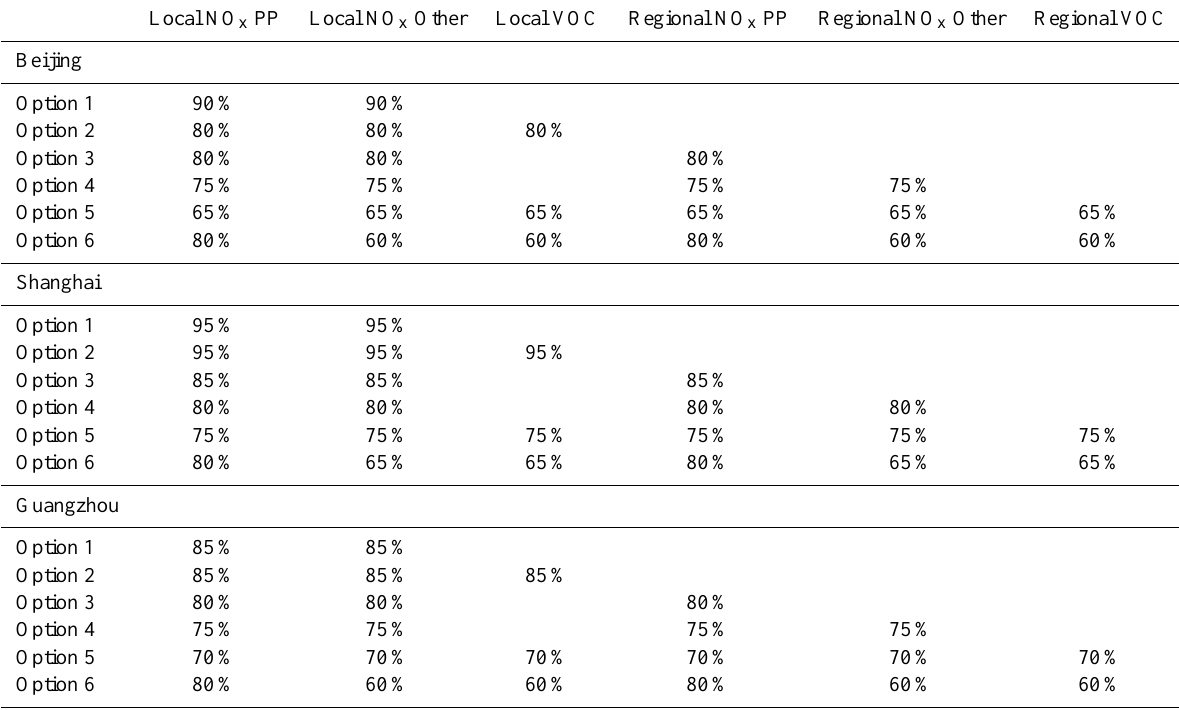
Table 4. Optional NO x /VOC emission reduction ratios to meet the National Ambient Air Quality Standard in China for ozone, Class I (1-h maximal concentration, 160 µgm − 3 )